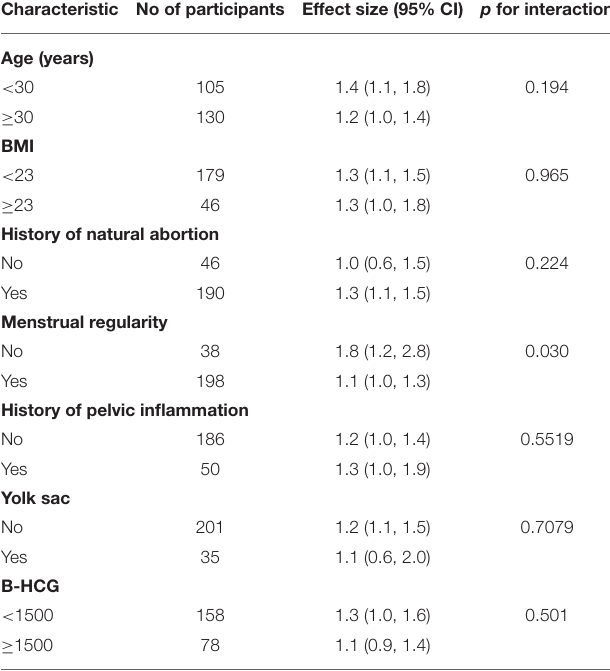
TABLE 4 | Results of subgroup analysis and interaction